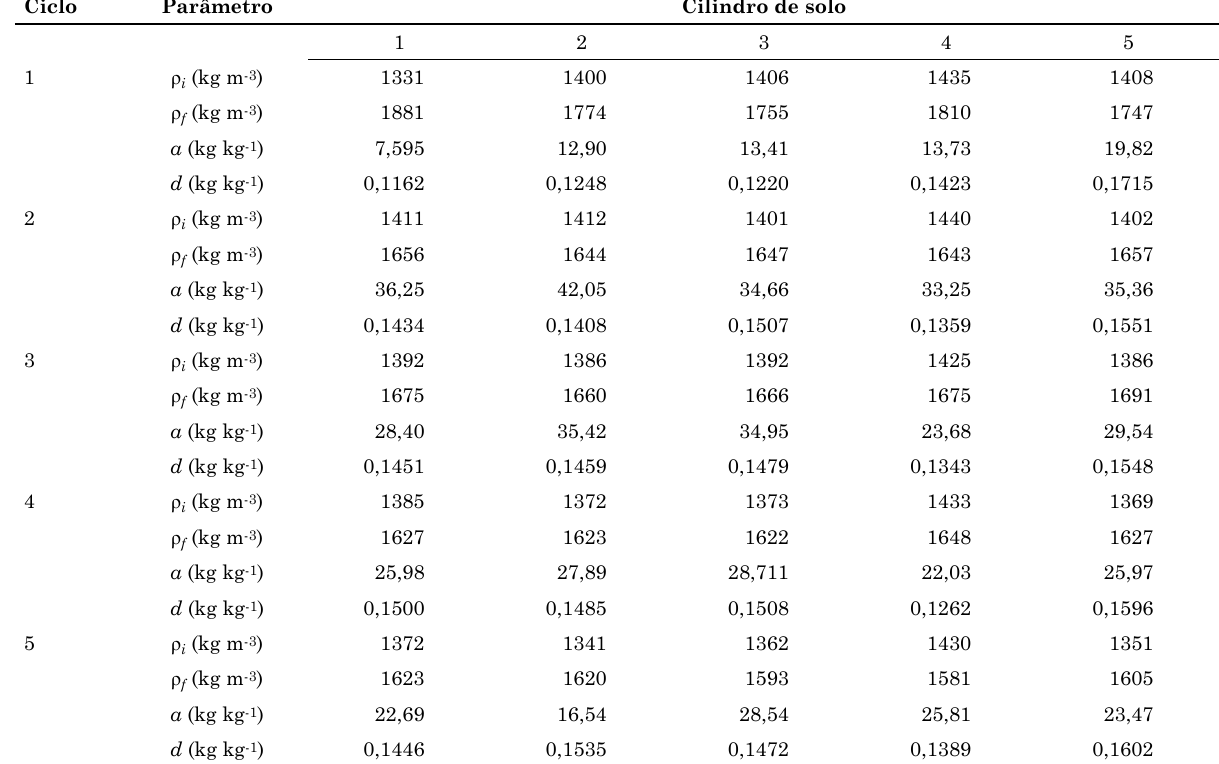
Quadro 1. Valores estimados dos parâmetros de ajuste da equação 1 para todas as amostras e ciclos de contração e